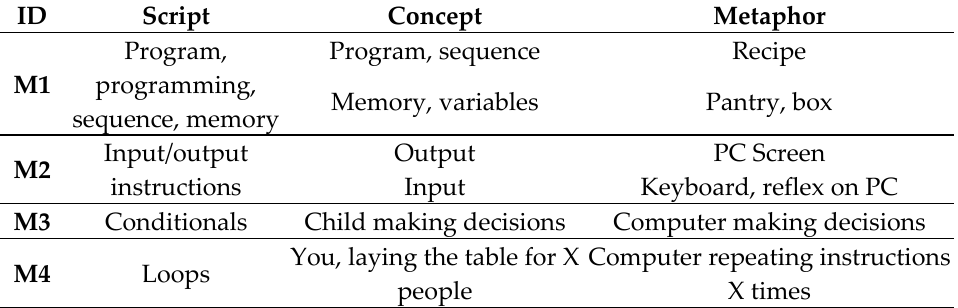
Table 1. Example of metaphors